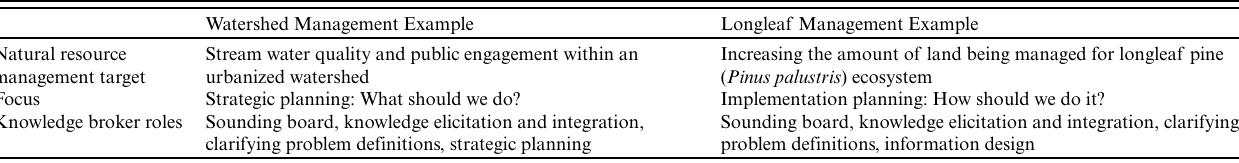
Table 3 . Comparison of key characteristics of the two illustrative